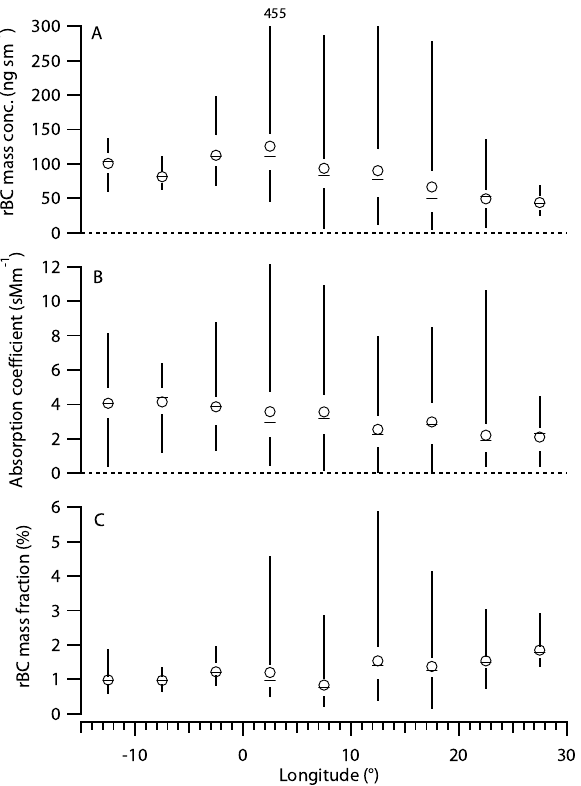
Fig. 4. Whisker plots showing the statistics for (a) SP2-measured refractory black carbon (rBC) mass concentrations, (b) PSAP- measured absorption coefficients and (c) rBC mass fractions (cal- culated from rBC mass concentrations and PCASP-estimated mass concentrations) for 5 ◦ longitude bins during the EUCAARI- LONGREX component of the campaign. Whiskers indicate the minimum value to 25th percentile and 75th percentile to maximum value. Medians are indicated by horizontal lines, means by circles and the number of individual measurements for each bin are indi- cated to the right of the data points. Note the number of measure- ments in each bin are not identical because of differences in data coverage for the SP2, PSAP and PCASP.